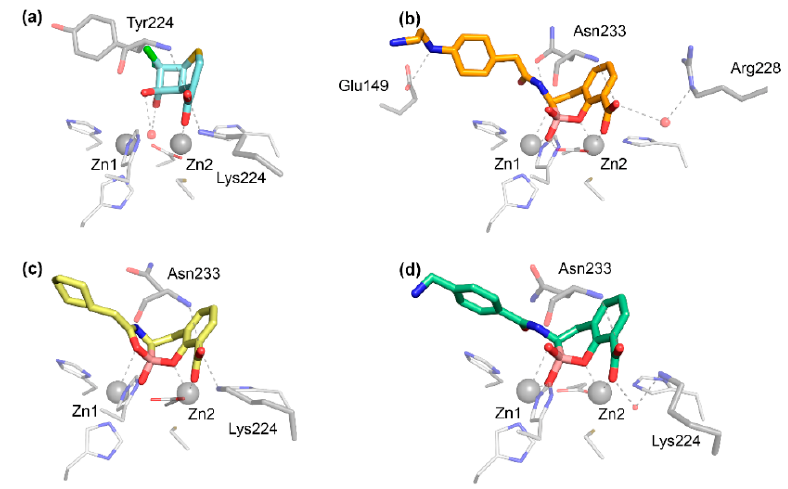
Figure 7. Binding mode of the transition state mimics. Crystal complexes of ( a ) cyclobutanone:SPM-1 (PDB 5ndm) [193], ( b ) Taniborbactam:VIM-2 (PDB 6sp7) [183], ( c ) Taniborbactam:NDM-1 (chain B PDB 6rmf) [162], and ( d ) 14 :BcII (PDB 5fqb) [147]. Hydrogen bonds and metal ligands interactions are drawn with dashed lines.